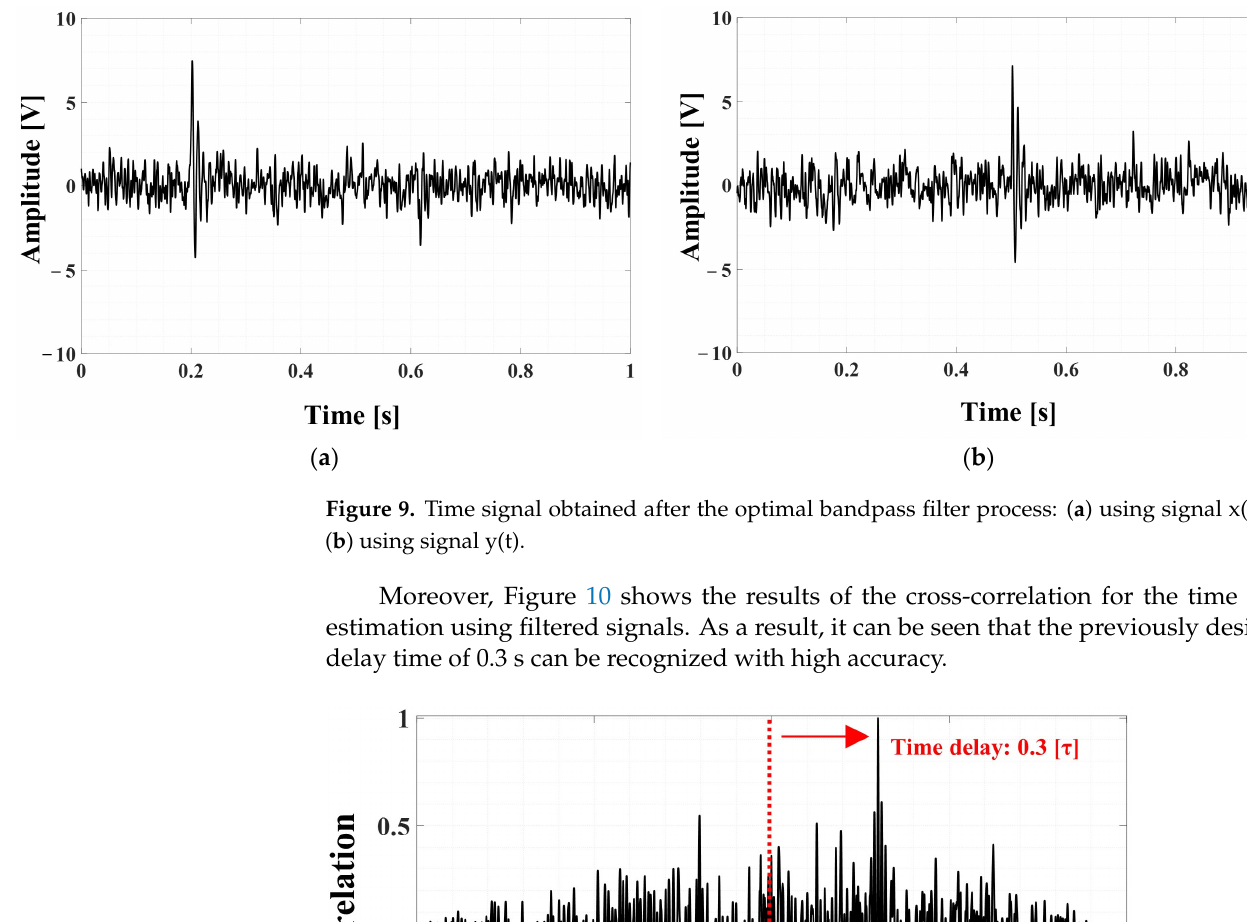
Figure 10. Cross-correlation using fi ltered signals.